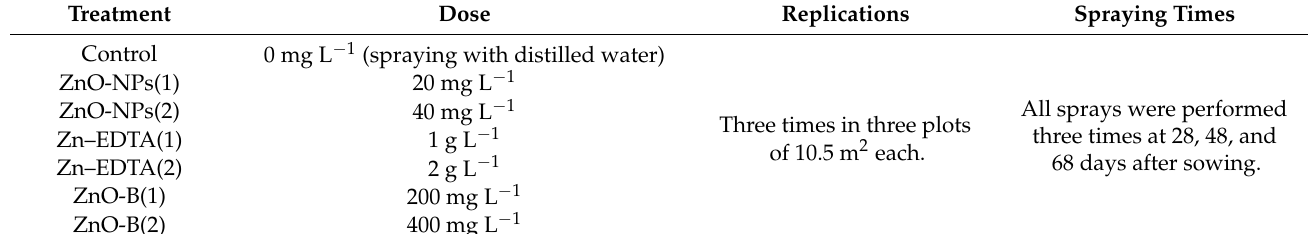
Table 3. The description of the experimental treatments.